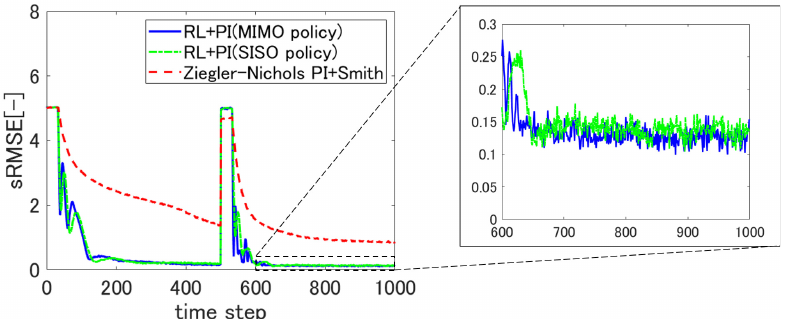
Figure 9. Changes in sRMSE metrics when the reference thickness is changed from 70 to 65 at the 500th sampling